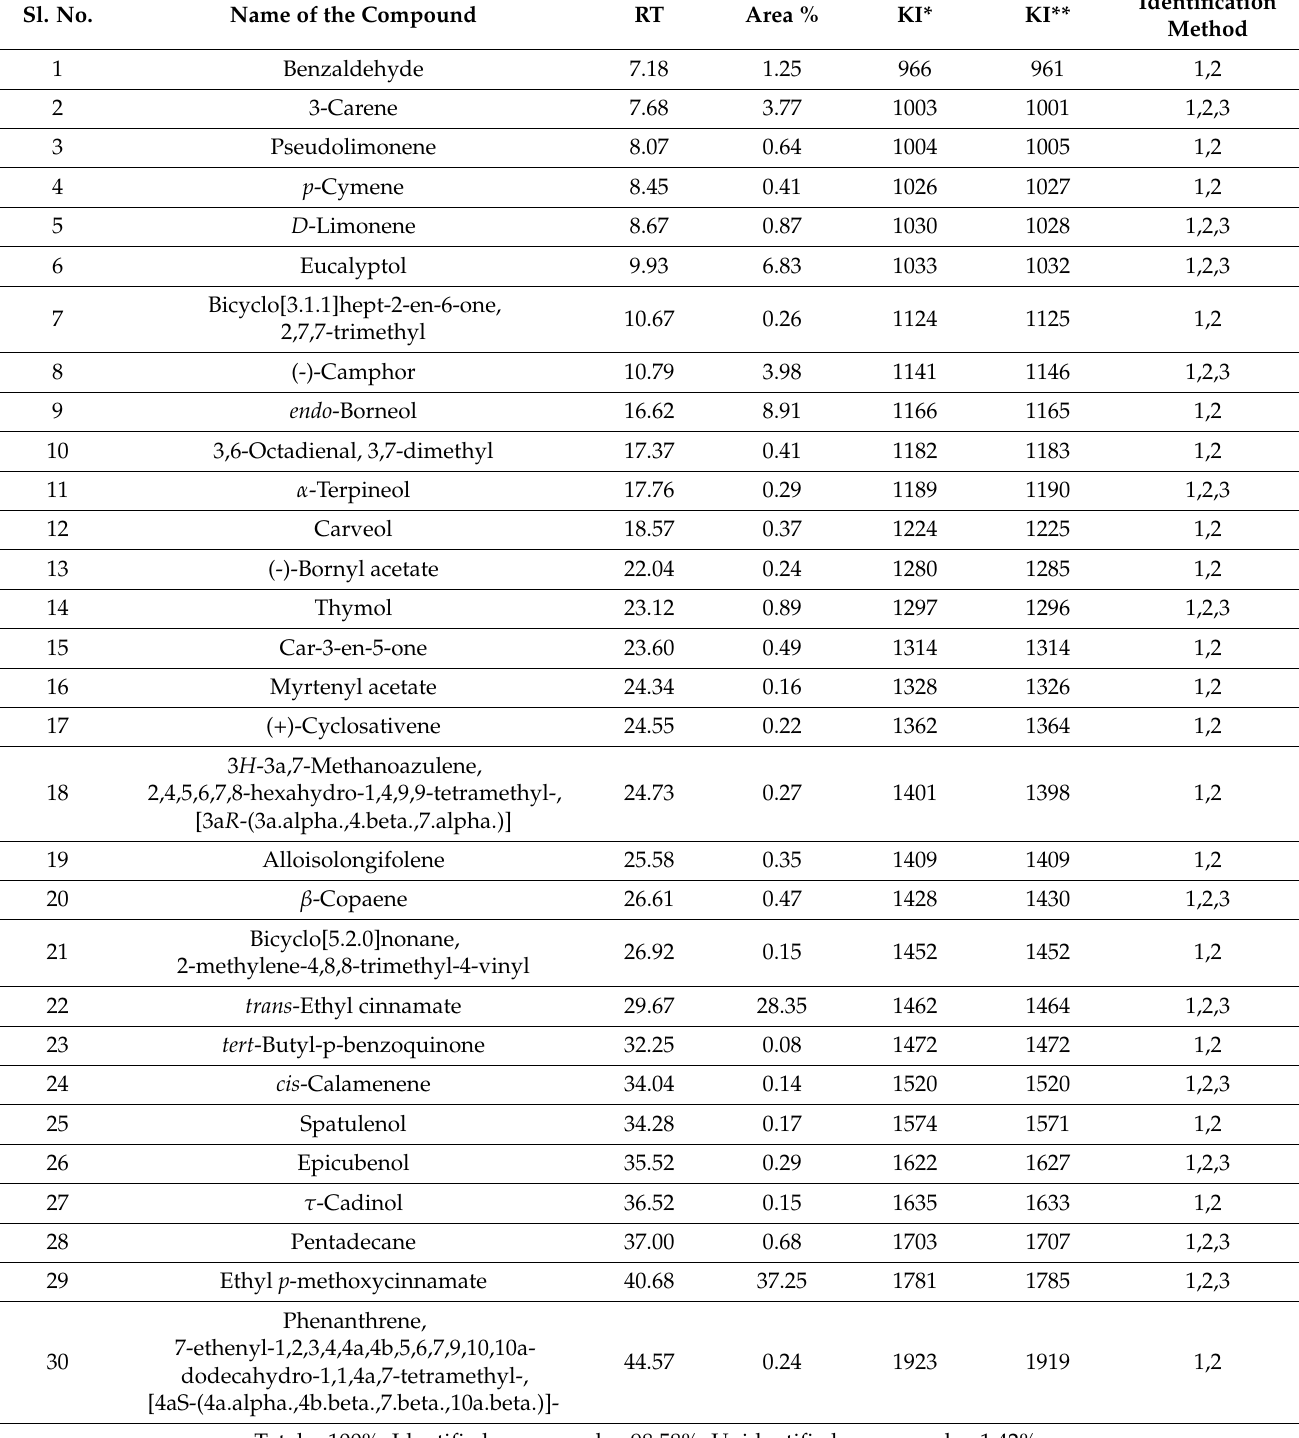
Table 7. GC/MS analysis of the rhizome essential oil of the registered germplasm “Bharamputra-1”. Sl.